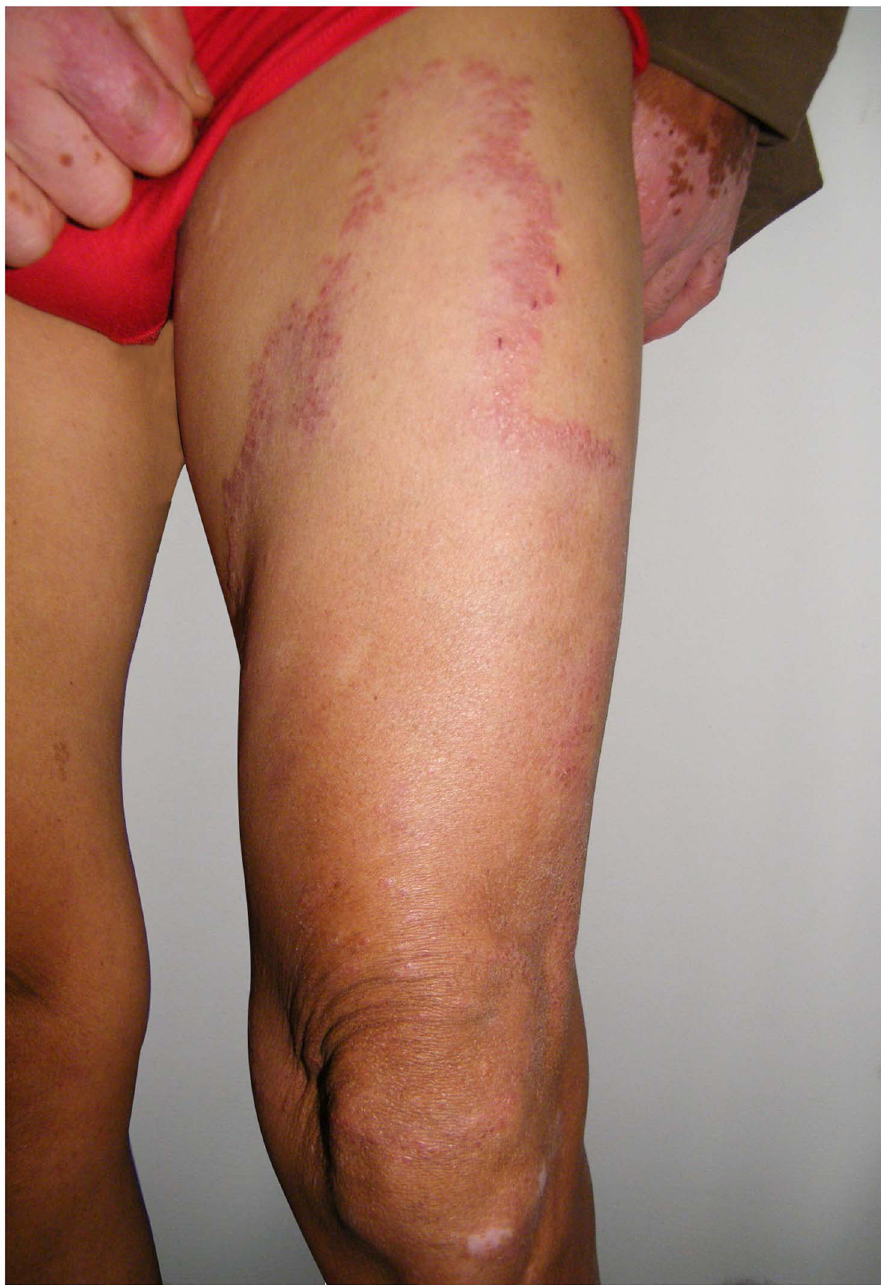
Figure 1. Clinical manifestations of the first patient when he was admitted in our clinics for the first time. Erythema and papules could be observed on the right leg with clear